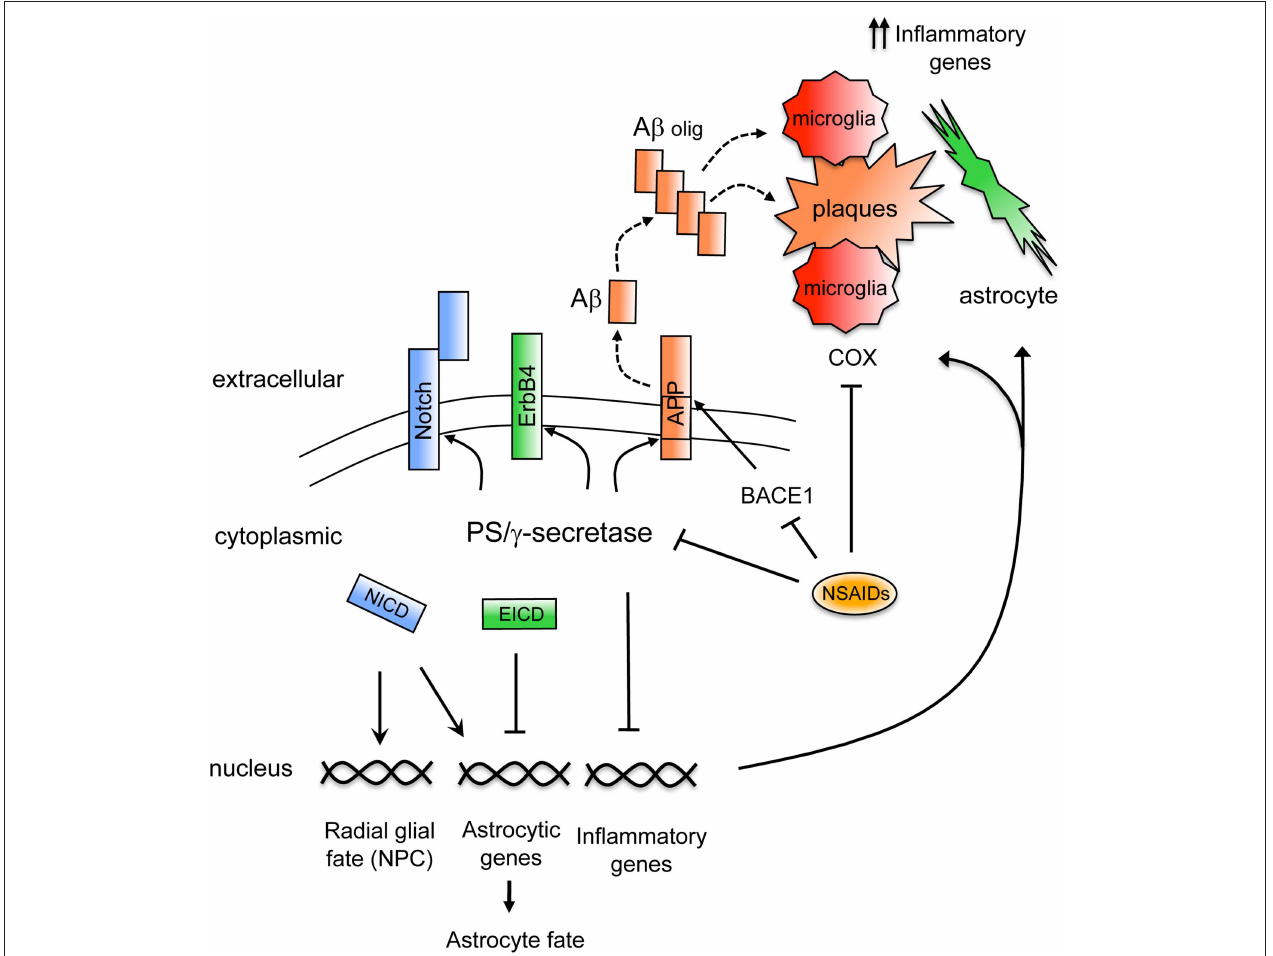
FIgure  | Mechanisms regulating brain inflammation by PS/ γ ‑secretase. Schematic model showing signaling mechanisms regulated by PS/ γ -secretase on inflammation. The γ -secretase-dependent cleavage of APP generates the A β peptide that following oligomerization (A β olig) accumulates in plaques in AD brain (dashed lines). A β stimulates inflammatory cells that upon activation upregulate proinflammatory genes and secrete inflammatory molecules. Activated microglia and reactive astrocytes accumulate surrounding the amyloid plaques. Non-steroidal anti-inflammatory drugs (NSAIDs) reduce inflammation by acting through different molecular